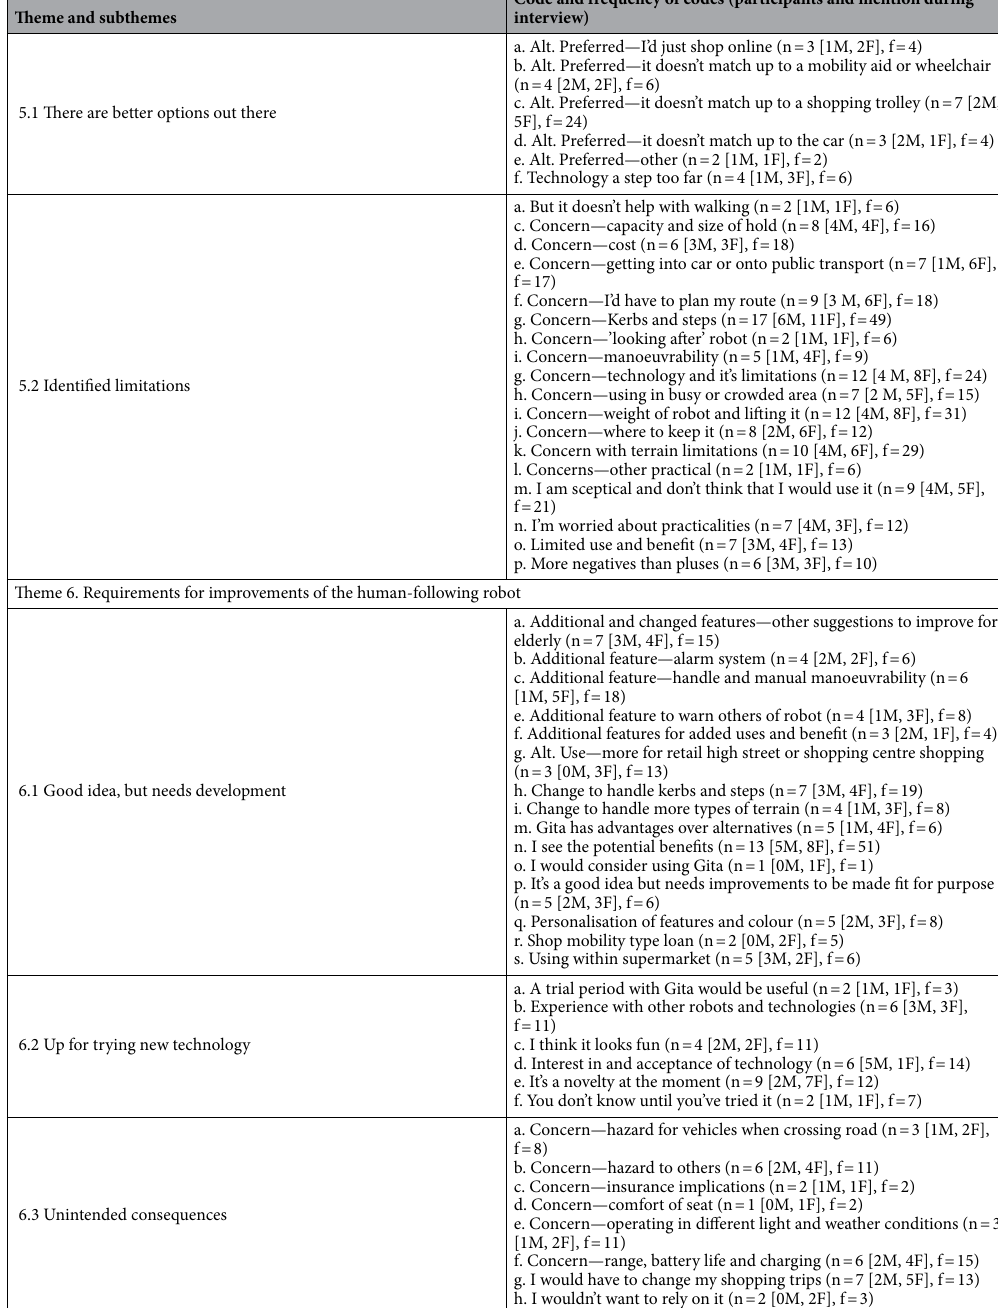
Table 1. Summary of thematic analysis. n number of participants, M male, F female, f number of code